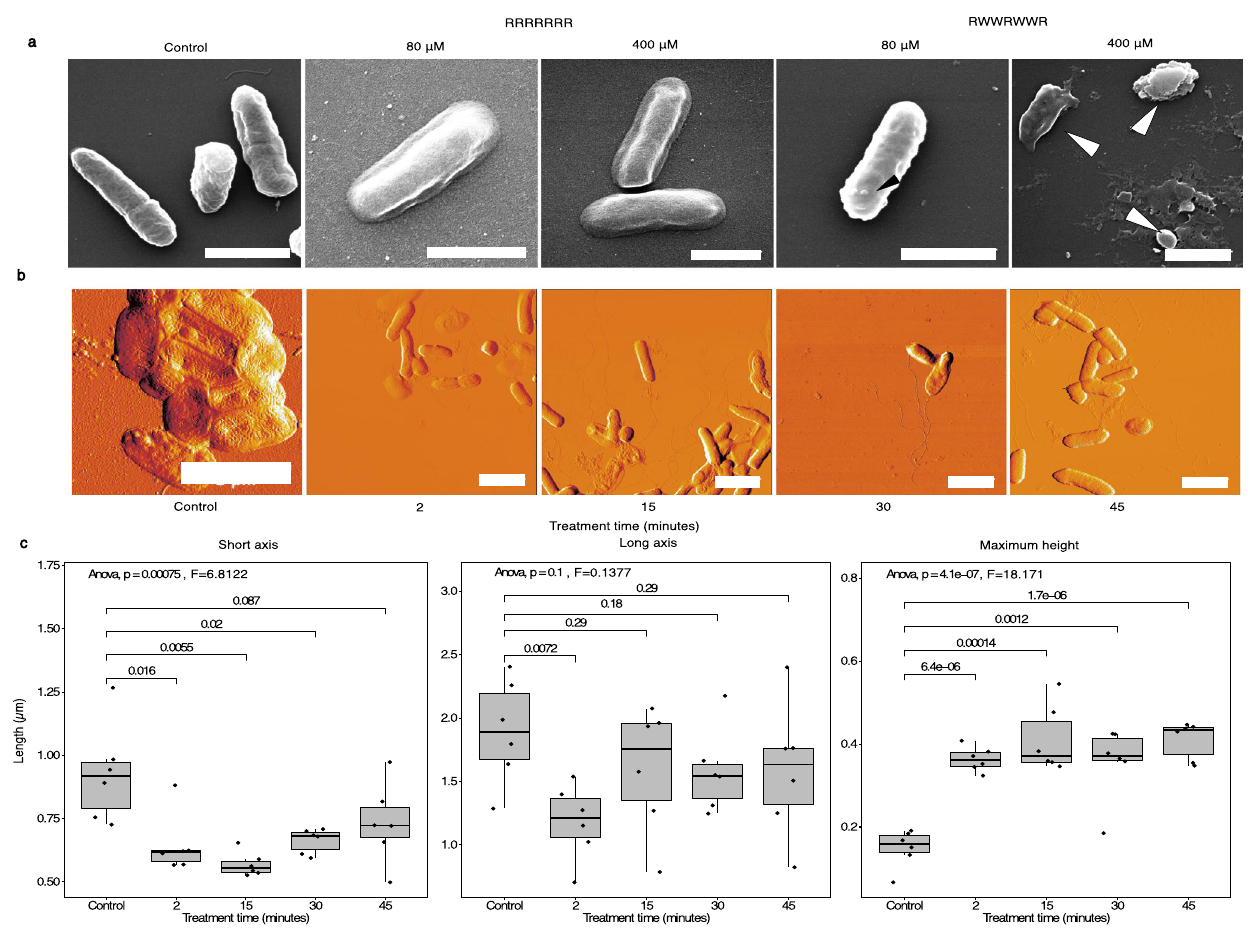
Fig. 5 Effects of antimicrobial peptides on bacterial ultrastucture. a Appearance of P. aeruginosa bacteria treated with the peptides RWWRWWR and RRRRRRR at concentrations of 80 and 400 µ M, visualised by SEM. A control image of bacteria not treated with peptide is also shown. Black arrow indicates a localised protrusion (bleb) on the surface of the bacteria. White arrows indicate debris, presumably from lysed bacteria. White scalebars shown are 1 µ m in length. b Appearance of P. aeruginosa bacteria treated with the peptides 80 µ M RWWRWWR for various time periods, visualised by AFM. A control image of bacteria that were not treated with peptide is also shown. White scalebars shown are 2 µ M in length. c Quanti fi cation of the average change in size of bacteria after peptide treatment for various times. Boxplots show the long axis, short axis and maximal heights of bacteria in typical AFM images from ( b ). Numbers on brackets indicate the P value from a post hoc Tukey test for time points where distributions either end of the bracket are signi fi cantly different. n = 6 cells used for analysis at each time